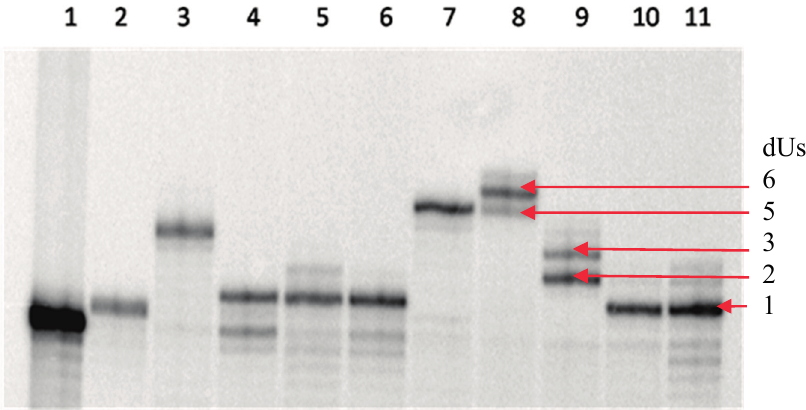
Figure 2. Screening various DNA polymerases with compound 1A and T1 . Lane 1, primer only; lane 2, ddTTP (control); lane 3, dTTP (control); lane 4, Tth; lane 5, Tfl; lane 6, Thermosequenase; lane 7, Vent(exo-); lane 8, Therminator; lane 9, KOD DASH; lane 10, Klenow; lane 11, Sequenase